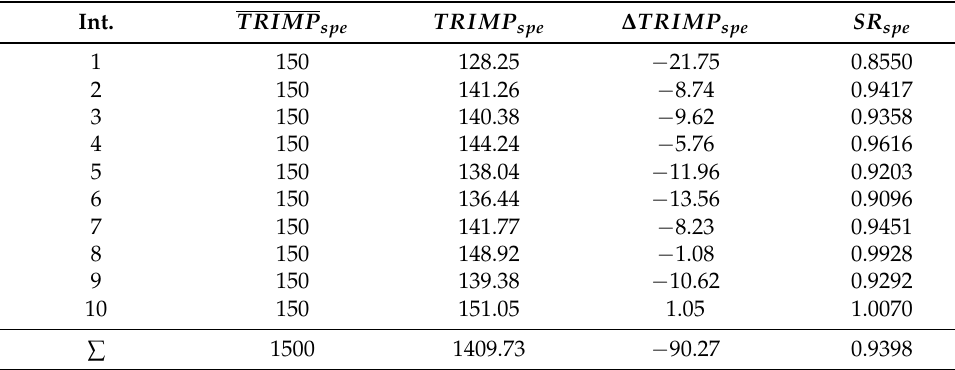
Table 5. Amateur cyclist results by interval speed phase.